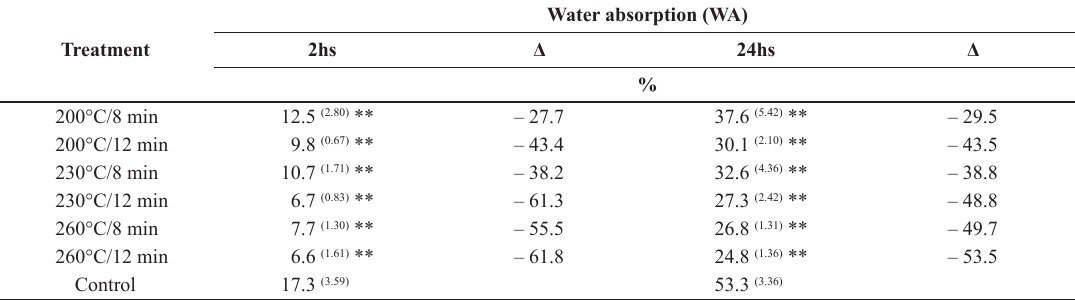
Table 3. Water absorption of cane bagasse particleboard.